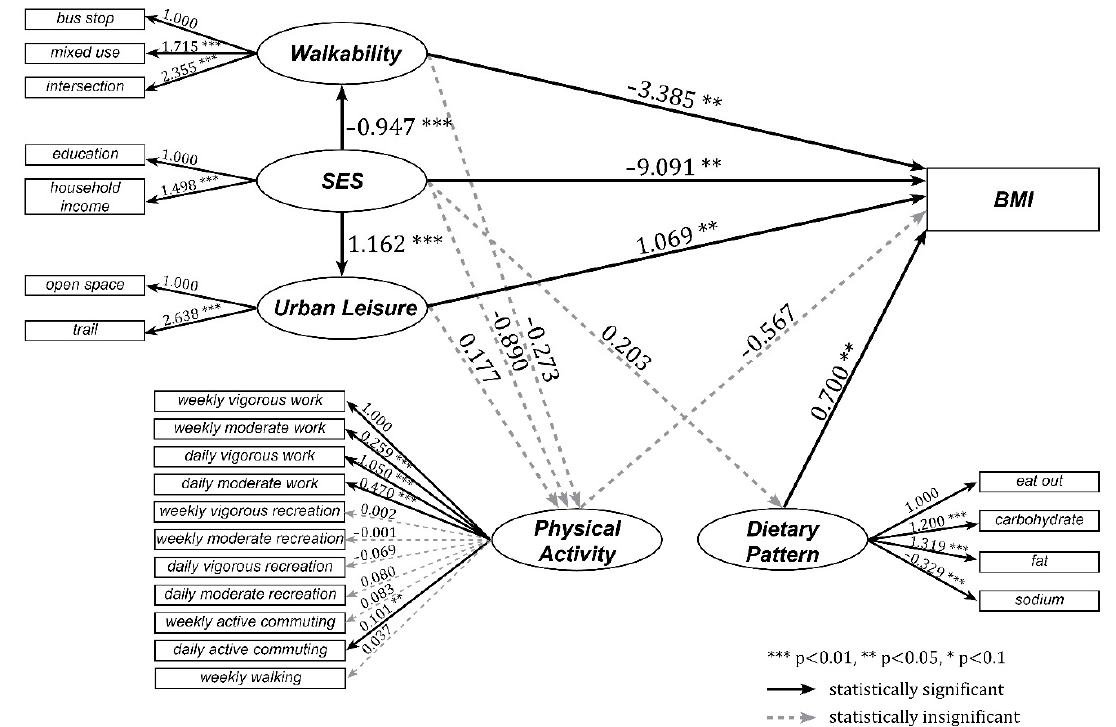
Figure 4. The results of analysis of how neighborhood environment effects BMI.